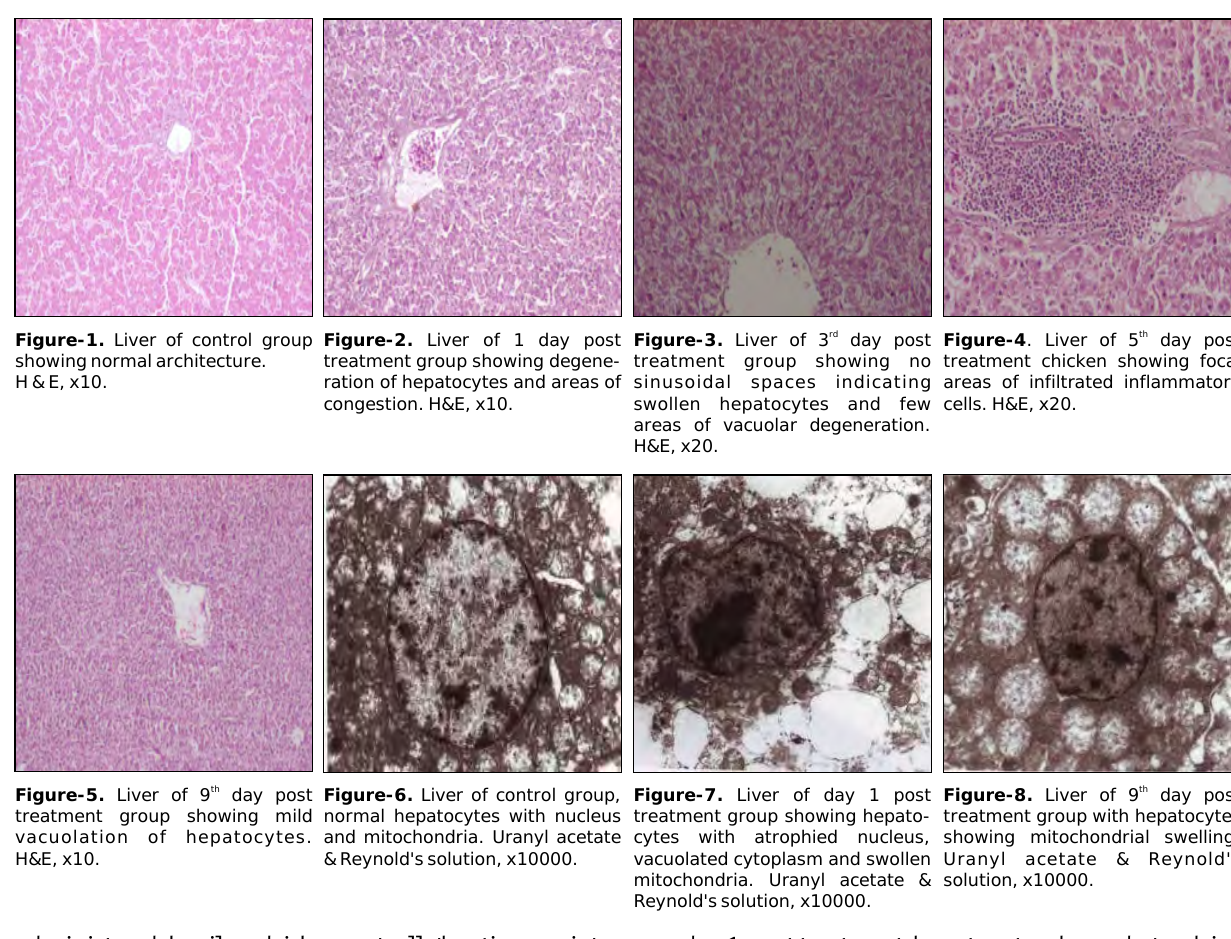
Figure-7. Liver of day 1 post treatment group showing hepato- cytes with atrophied nucleus, vacuolated cytoplasm and swollen mitochondria. Uranyl acetate & Reynold's solution, x10000.